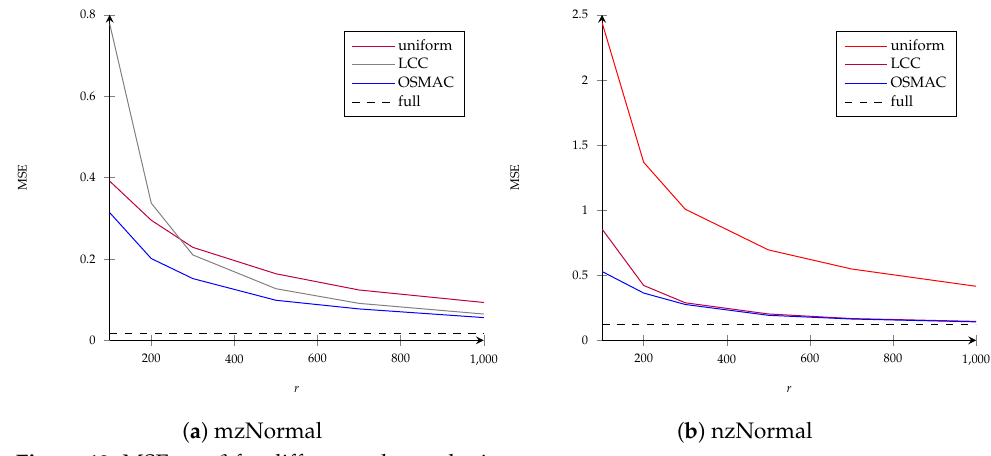
Figure 12. MSEs on β for different subsample sizes r